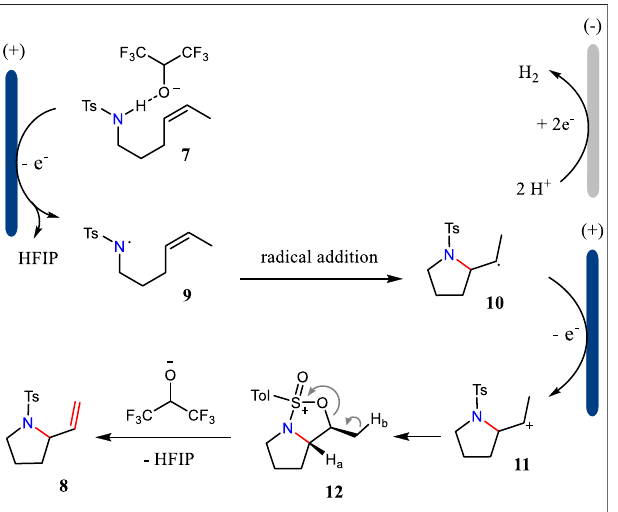
SCHEME 3 | The tandem reaction sequences for the aza-Wacker